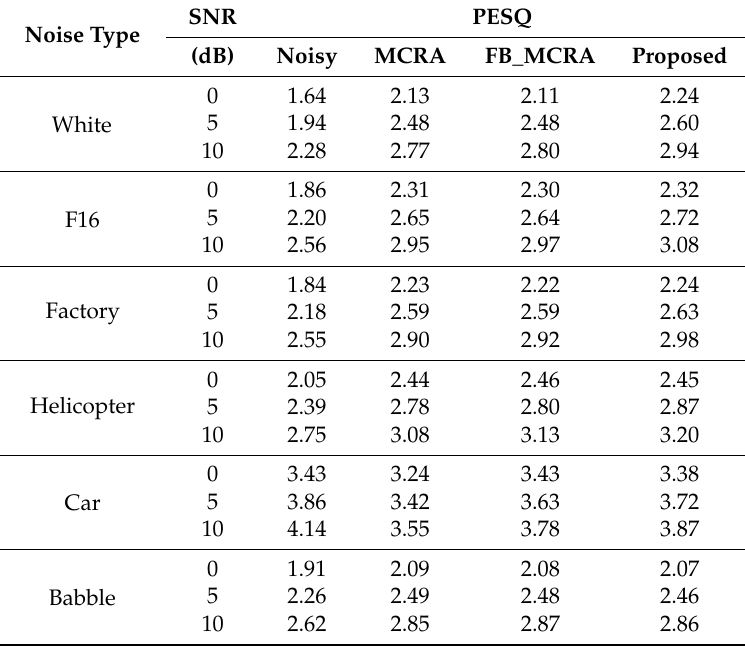
Table 2. Comparisons of perceptual evaluation of speech quality (PESQ) for the denoised speech in various noise corruptions. SNR PESQ Noise Type (dB) Noisy MCRA FB_MCRA Proposed